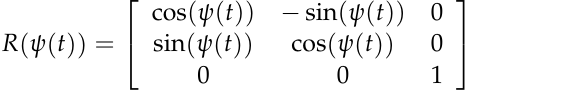
wide range, such as walls and canyons.